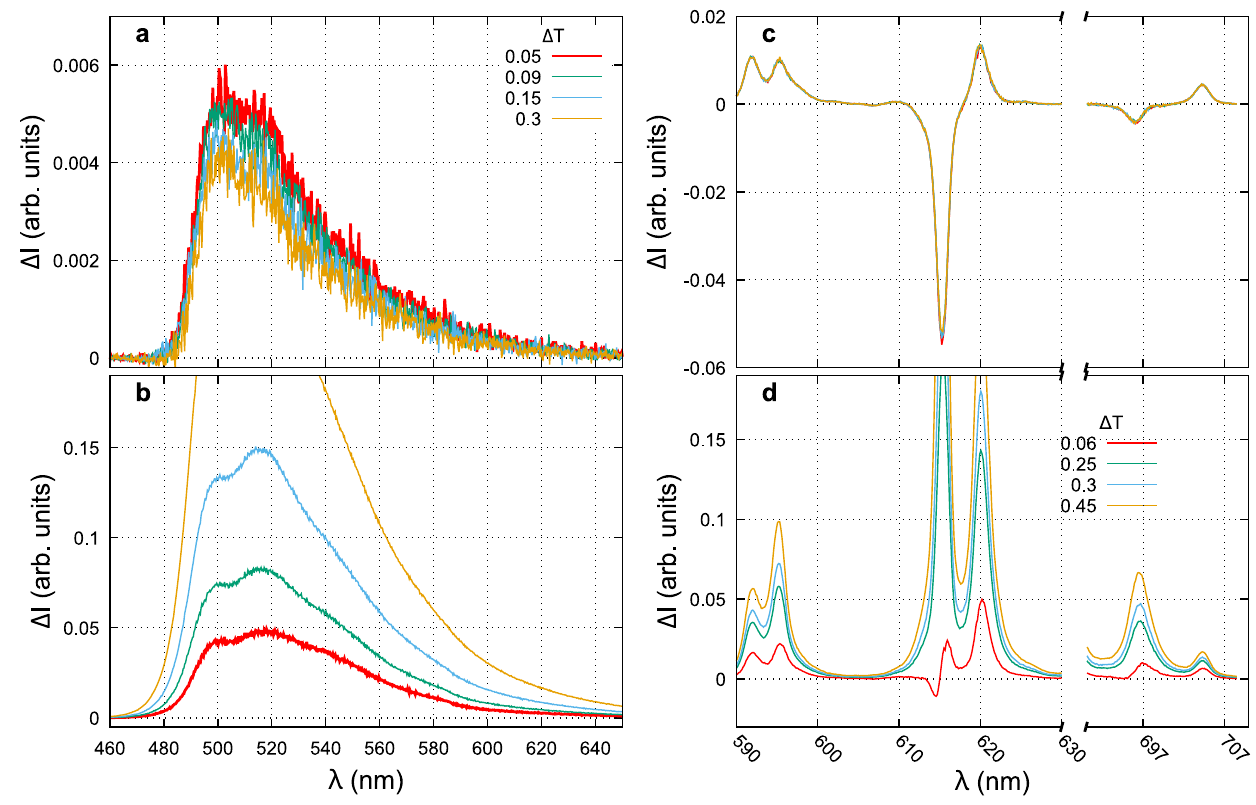
Fig.6|Artifactscomingfromarmsimbalance. CPLof 1 ( a , b )and 2 ( c , d )byusing either the artifacts-free procedure ( a , c ) or taking one single I L -I R difference ( b , d ). Note the y-axis different range between the top and bottom. The different curves